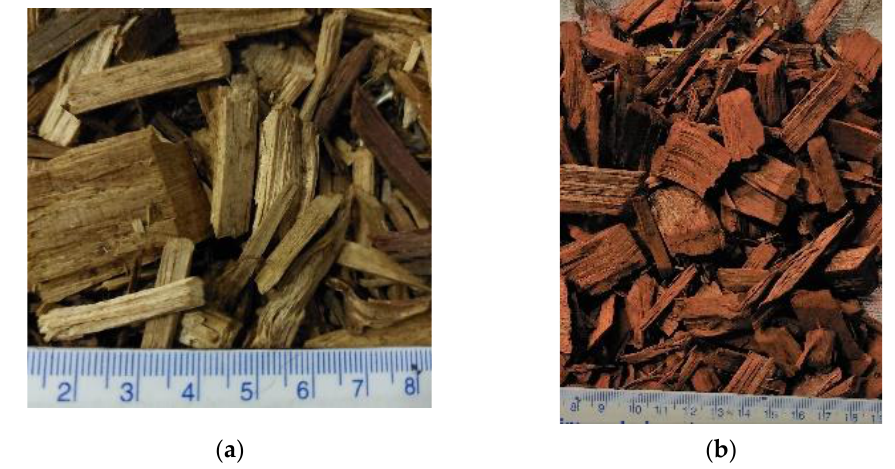
Figure 2. Two types of vegetation used in the study ( a ) cypress pine wood chips, ( b ) red gum wood chips.